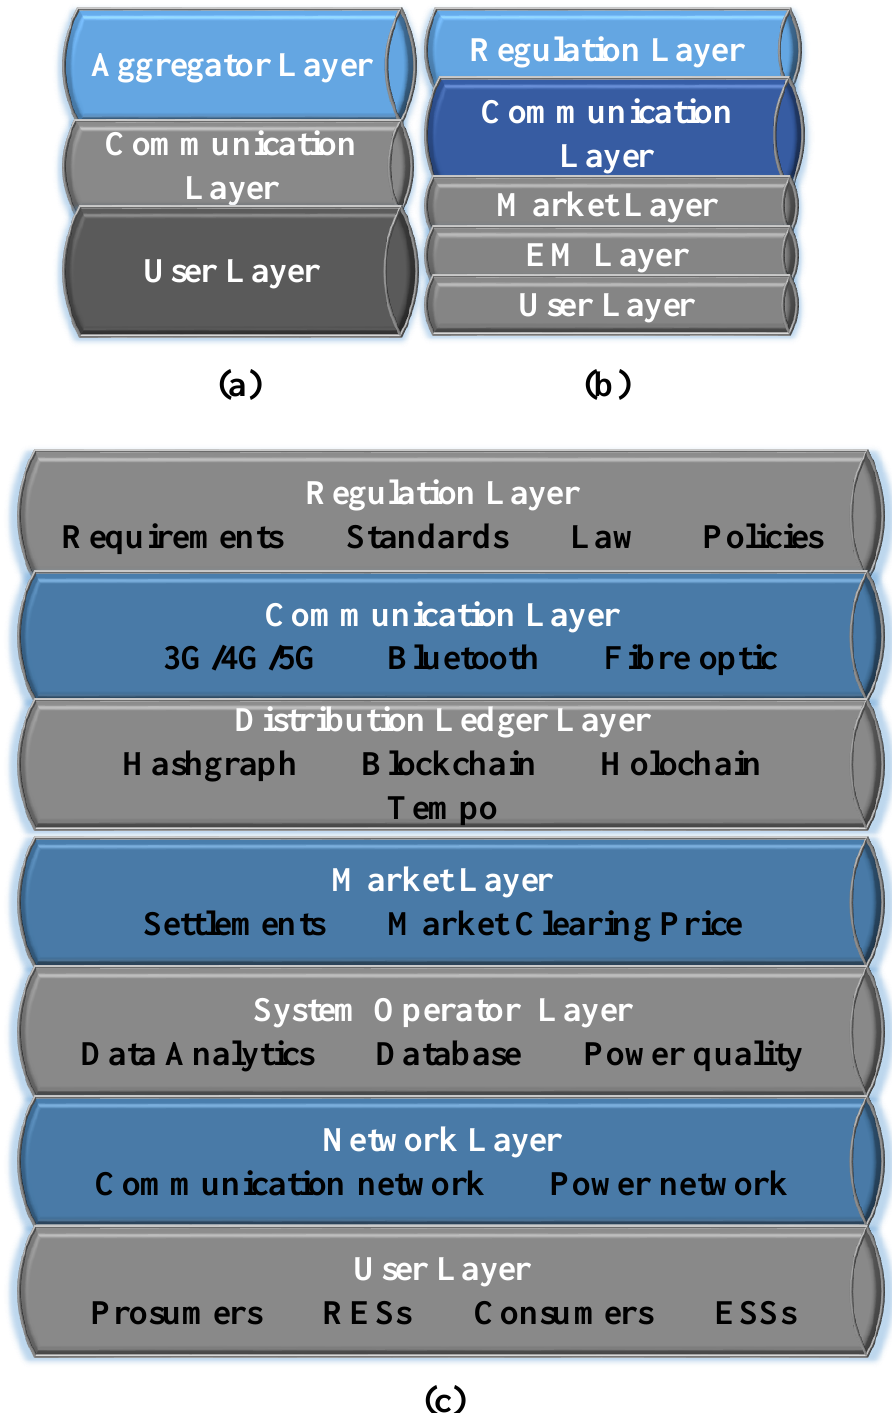
Figure 4. TE architecture: ( a ) 3-Layer [16] ( b ) 5-Layer [17] ( c ) 7-Layer